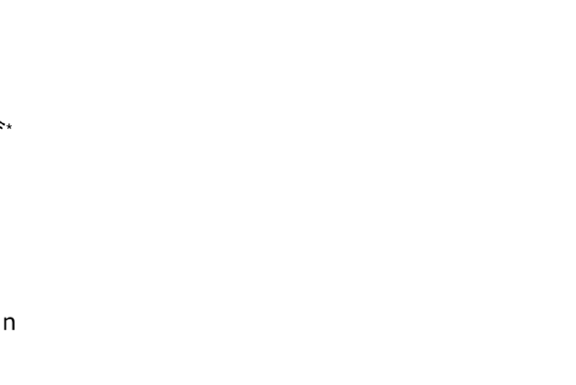
Figure 1. Molecular structures of the repeat units ( a ) MEH-PPP and ( b ) MEH-PPV.